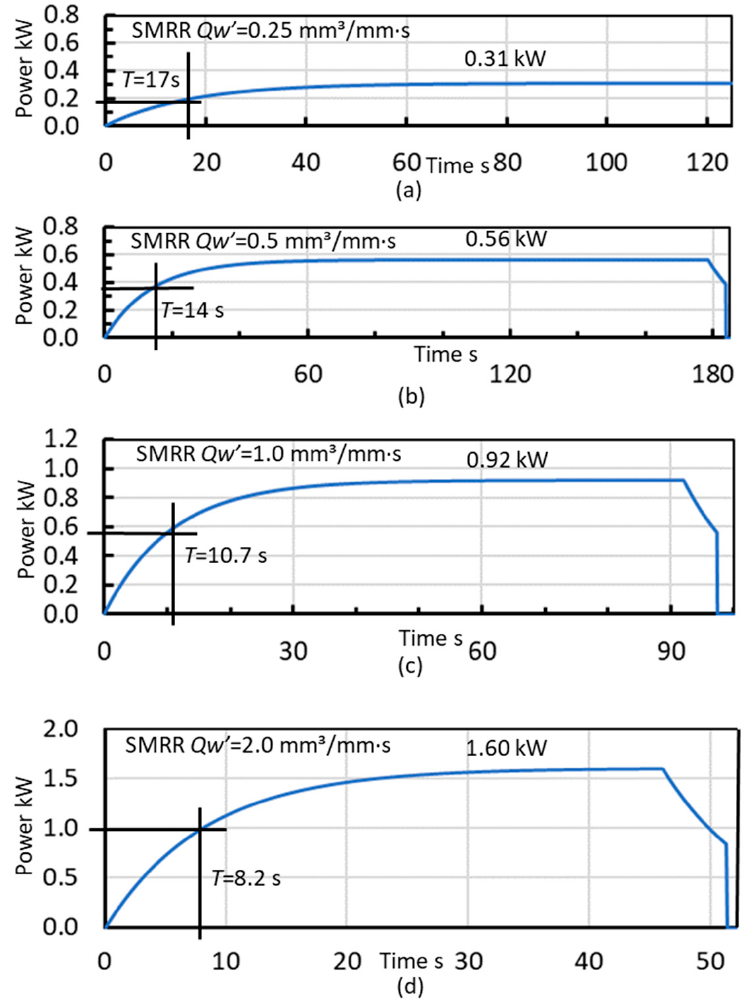
Figure 24. Simulations of plunge cylindrical grinding processes. ( a ) Q w (cid:48) = 0.25 mm 3 / mm · s; ( b ) Q w (cid:48) = 0.5 mm 3 / mm · s; ( c ) Q w (cid:48) = 1.0 mm 3 / mm · s; ( d ) Q w (cid:48) = 2.0 mm 3 / mm · s.